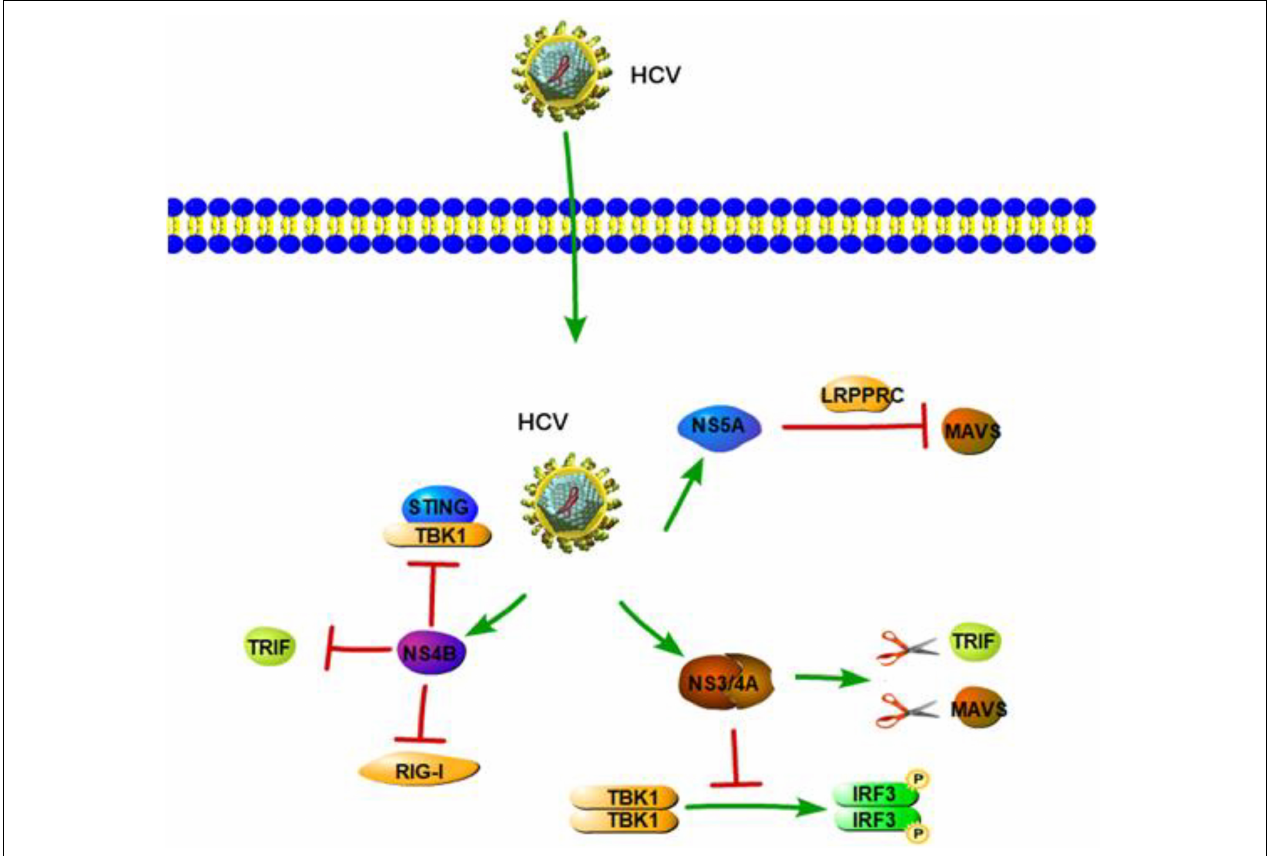
FIGURE 3 | Hepatitis C virus suppression of type I interferon (IFN) response (green arrows indicate the related signaling pathways and T-arrows in red indicate blocking the targets). HCV NS3/4A serine protease cleaves TRIF and MAVS to inhibit IFN-b pathway. HCV NS3 protein suppresses IRF-3 activation through disrupting the association between TBK1 and IRF3. NS4B suppresses RIG-I-mediated IFN- β production signaling through a direct protein interaction with STING or disrupting the interaction between STING and TBK1.NS4B also could inhibit TLR3-mediated IFN signaling by downregulating TRIF protein levels via caspase 8. NS5A is able to bind with LRPPRC and exploit the ability of LRPPRC to inhibit MAVS-regulated antiviral